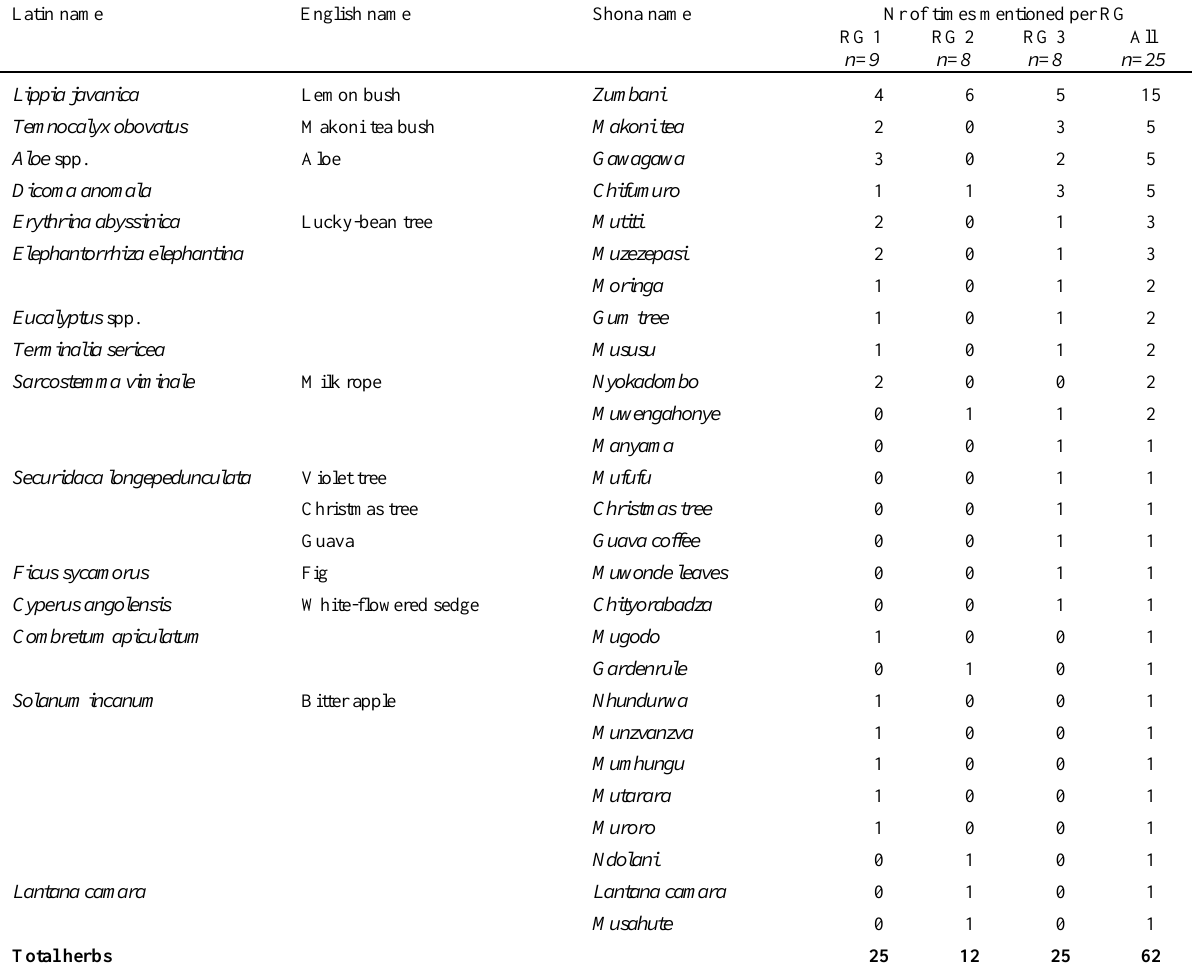
Table A3.4: Wild herbs and medicines, species names and collection scores.